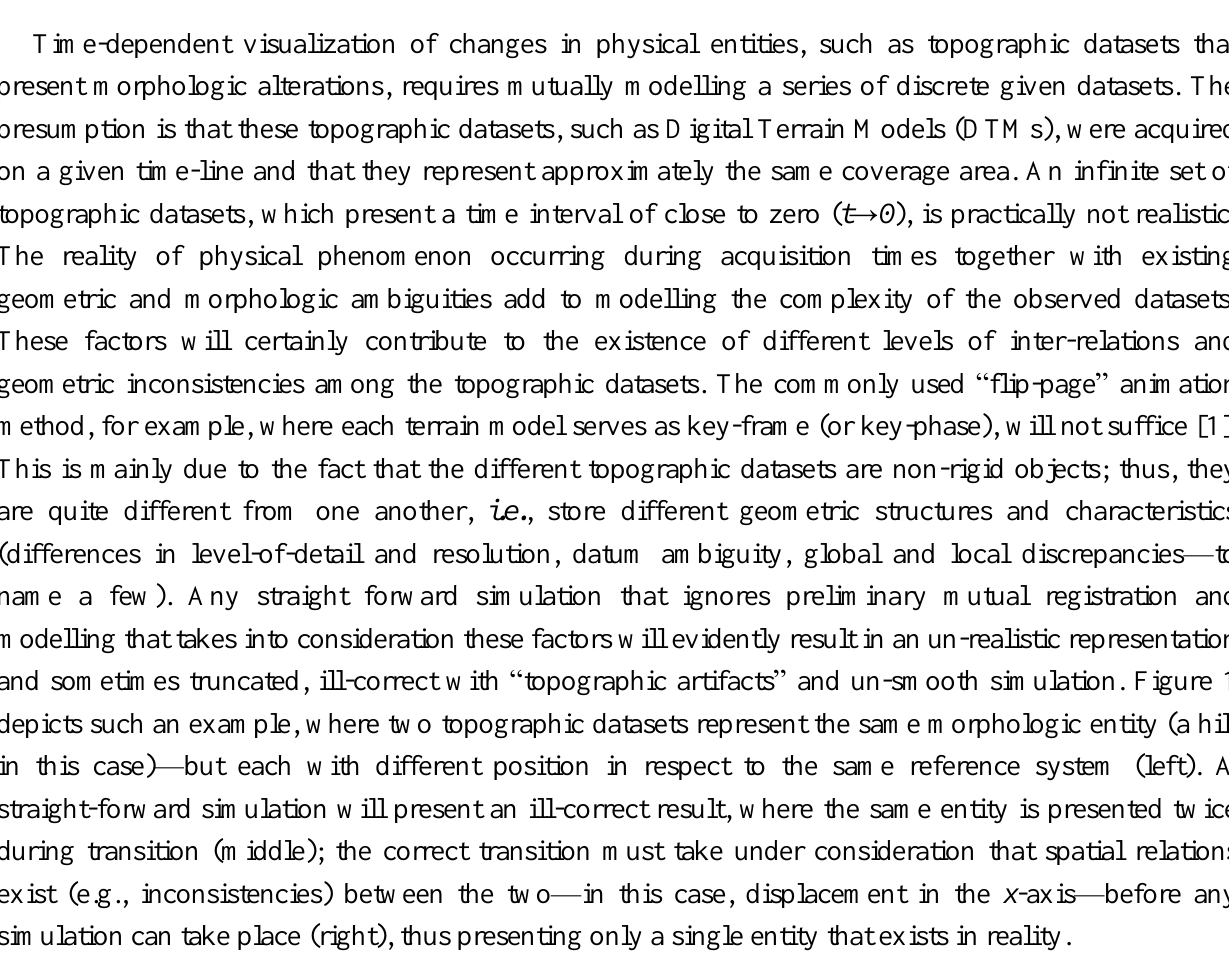
Figure 1. Two topographic datasets representing the same morphologic entity with different positions ( top-left and bottom-left ), an ill-correct straight-forward transition ( middle ) and desired transition ( right